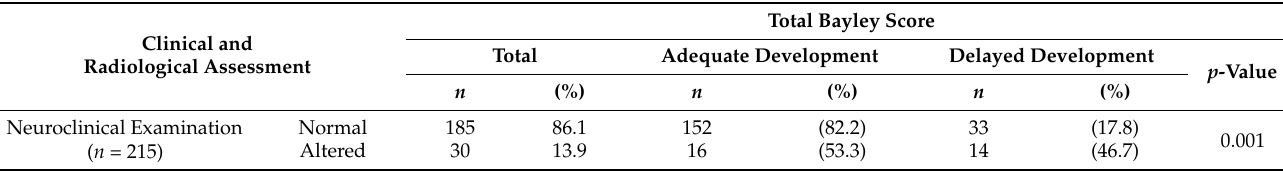
Table 3. Clinical and radiological association with performance on the BSID III test in the children with prenatal exposure to ZIKV born without